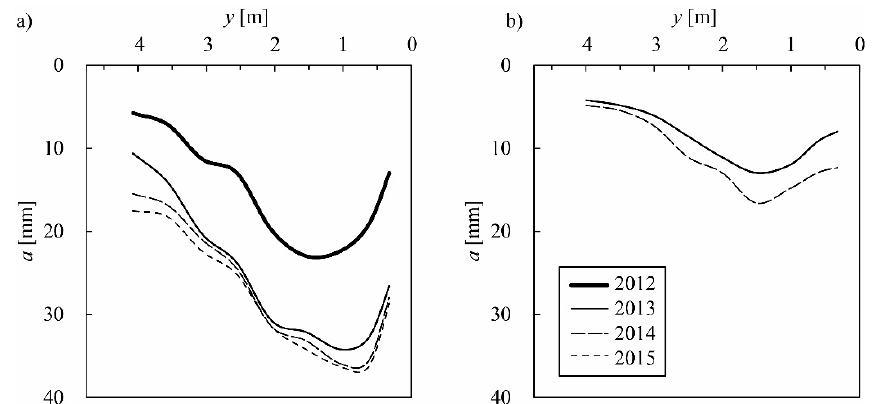
Figure 9. Super-elevated longitudinally averaged cross-sectional abrasion profiles of high-strength concrete test fields ( a ) C1 at test location 1 and ( b ) C2 at test location 2 installed at Pfaffensprung SBT for the years 2012 to 2015; view in flow direction.